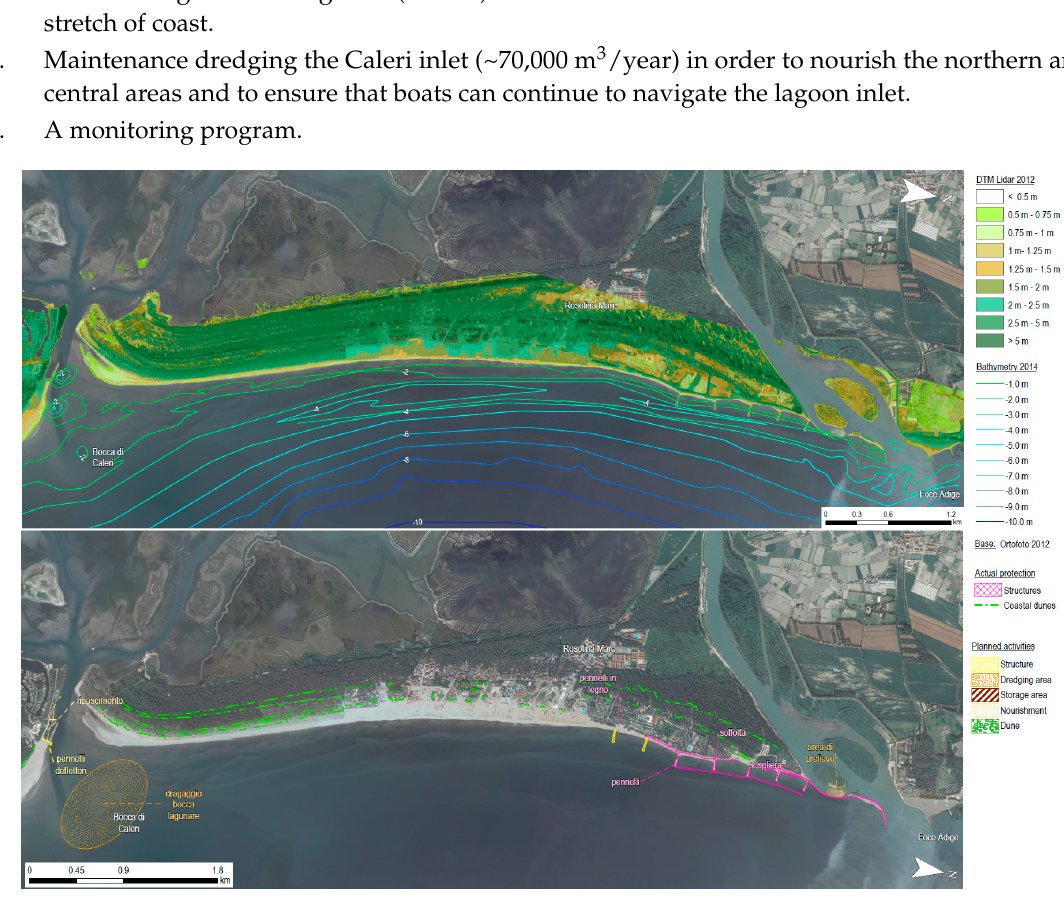
Figure 11. Topo-bathymetry (top) and adopted mitigation for the RO1 cell.